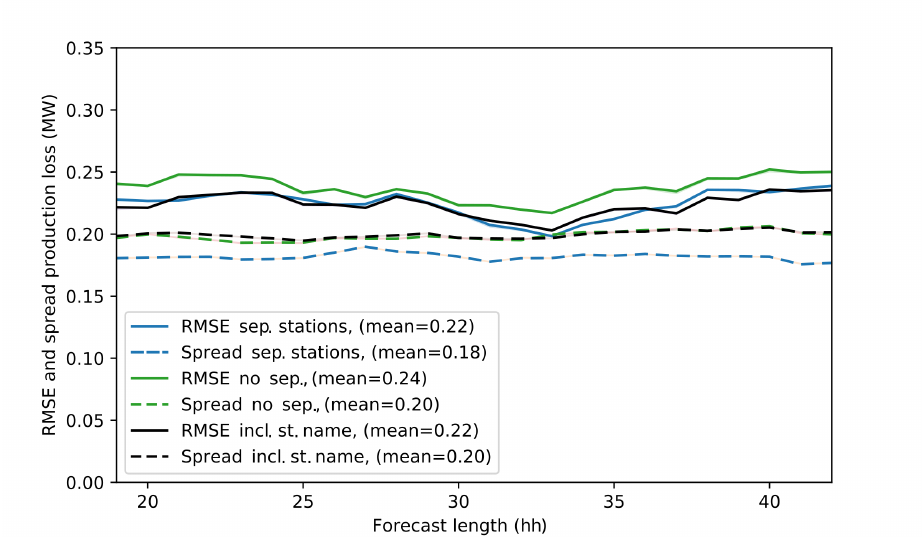
Figure 10. Spread in terms of the standard deviation of percentiles 95, 85 ...5 and forecast error in RMSE of the production loss forecast relative to observations for the next-day forecast